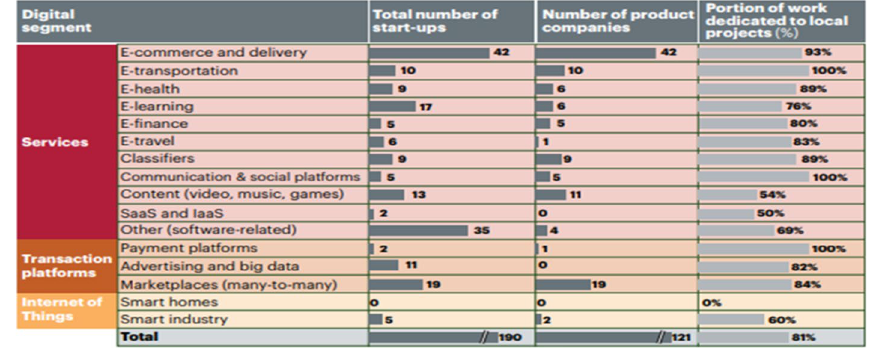
Fig. 1 Types of Start-ups in Bangladesh (Kearney,